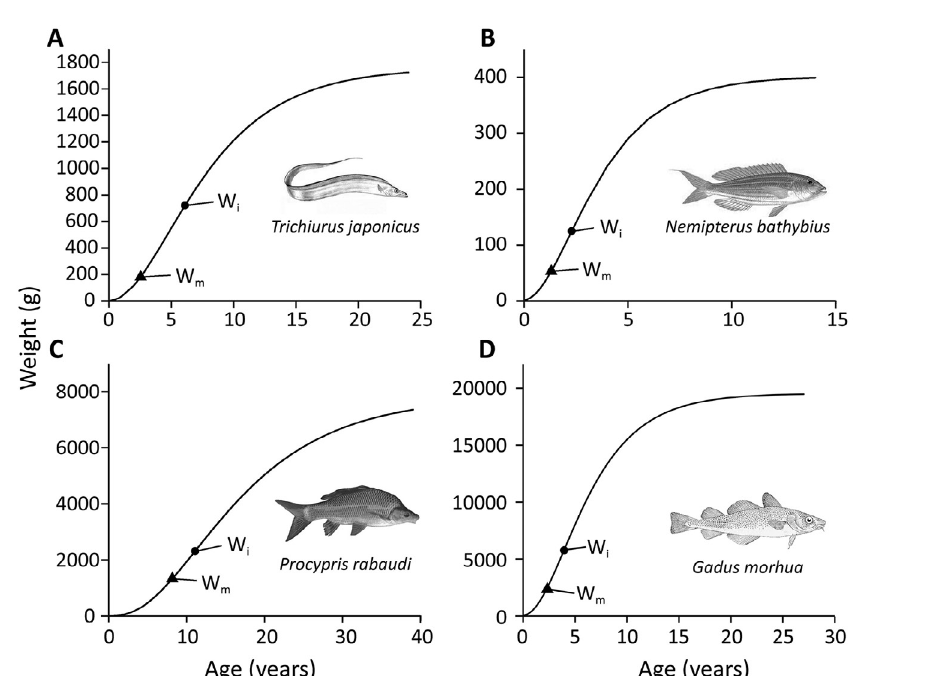
Fig. 2. – Illustrating the fact that, when growth in weight is considered, in fish reaching more than about 10 cm maximum length, the weight at first maturity (W ) is reached at a size at which growth is accelerating, i.e. well below the weight at which maximum growth rate is attained (at W i ); A , m largehead hairtail ( Trichiurus japonicus ) , based on data in Shi et al. (2020); B , yellowbelly threadfin bream ( Nemipterus bathybius ) , based on data in Li et al. (2009); C , rock carp Procypris rabaudi ), based on data in Wang et al. (2015); D , Atlantic cod ( Gadus morhua ), based on data in Le Franc